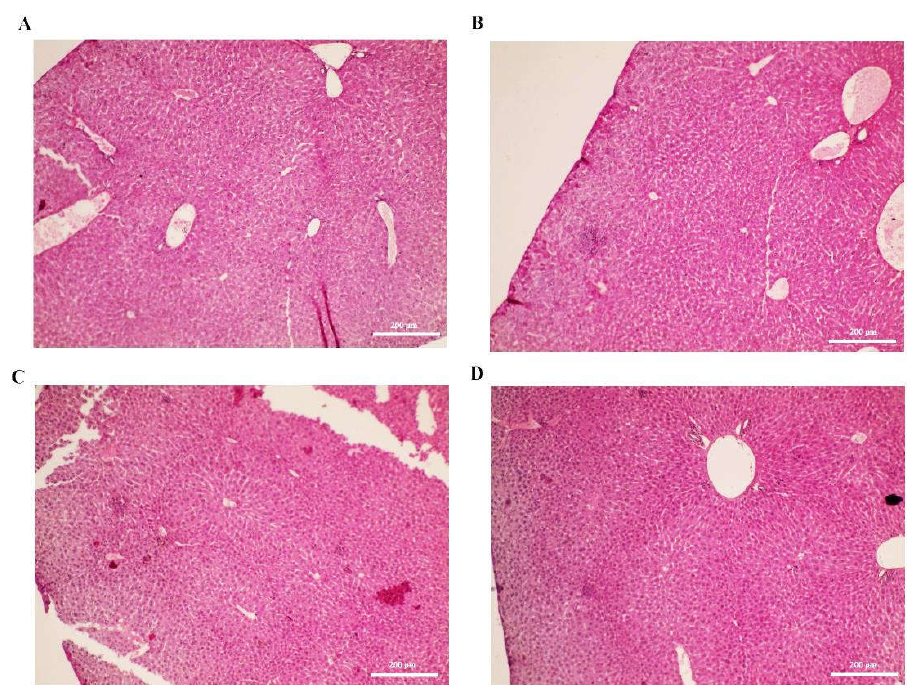
Figure 1. Morphological and histological evaluation of liver in mice. ( A ) Control group, ( B ) CCl 4 -treated group, ( C ) orientin (1 mg/kg)-treated group, and ( D ) CCl 4 orientin (1 mg/kg)-treated group. Magnification ×200 .